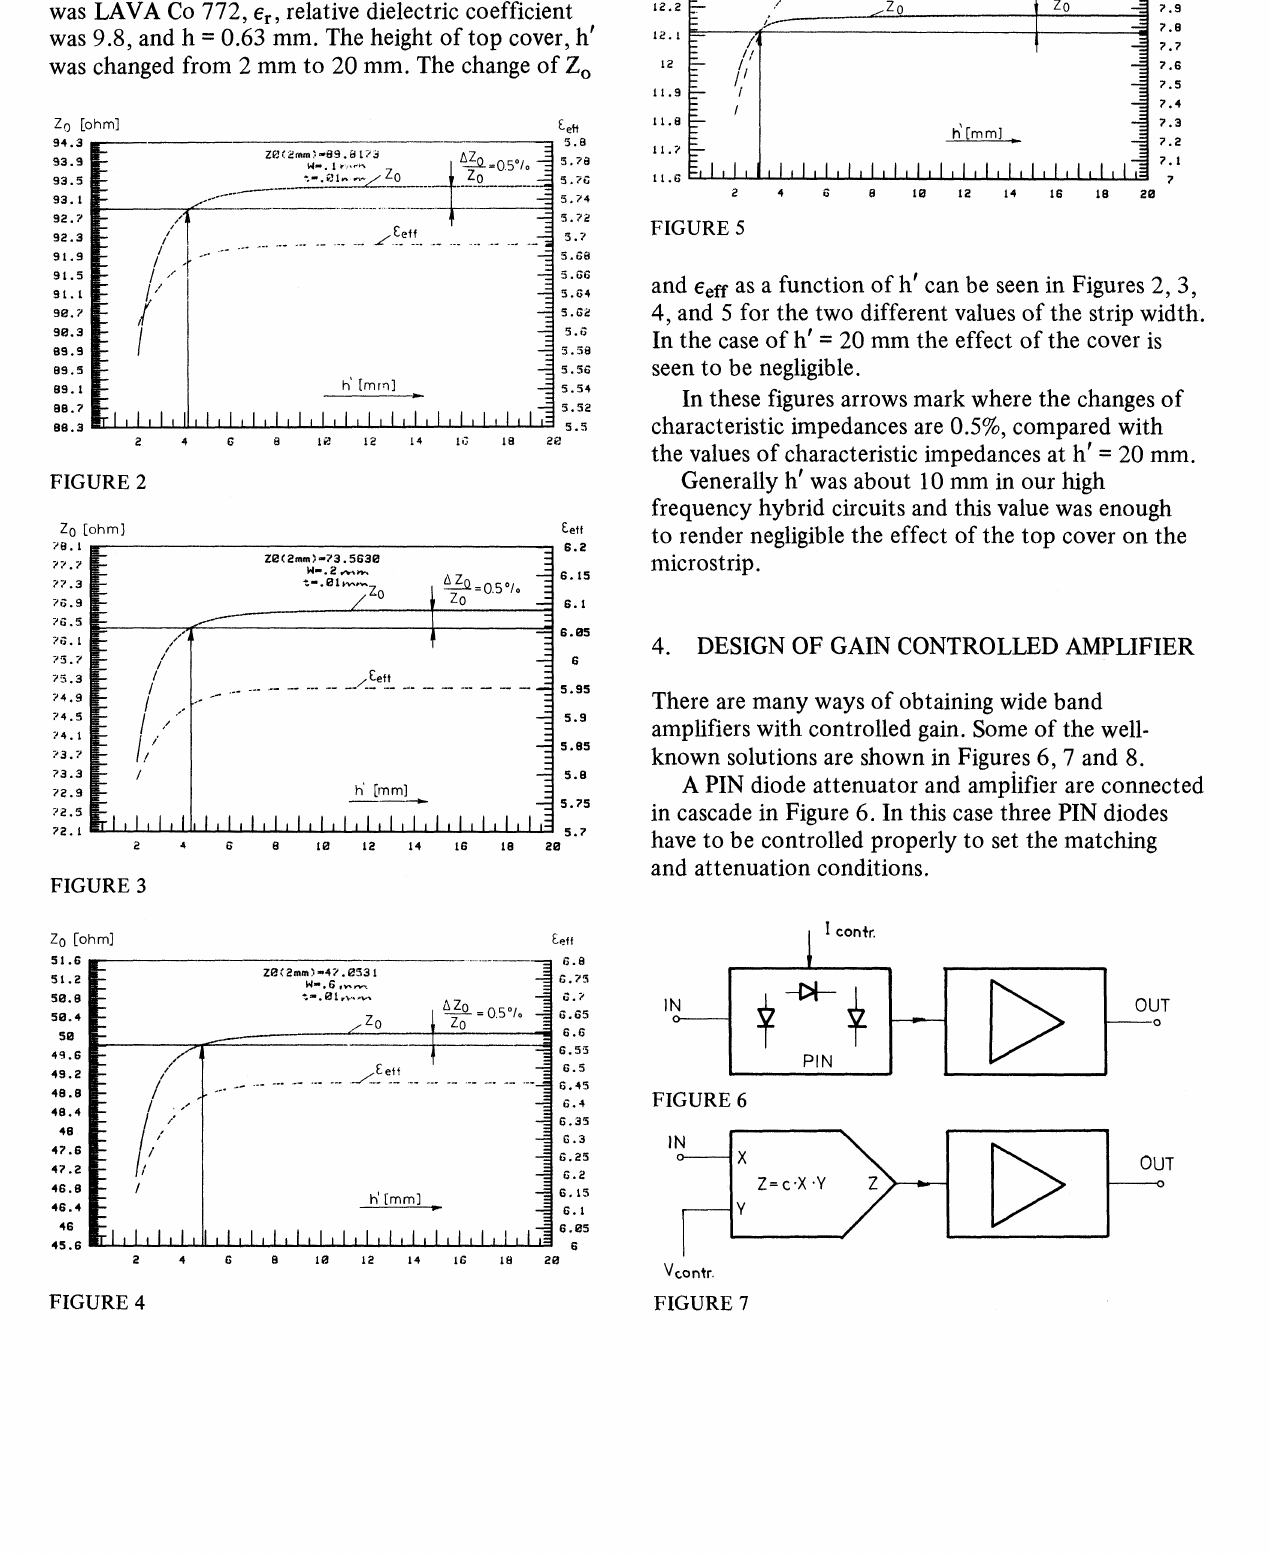
and eeff as a function of h’ can be seen in Figures 2, 3, 4, and 5 for the two different values of the strip width. In the case of h’ seen to be